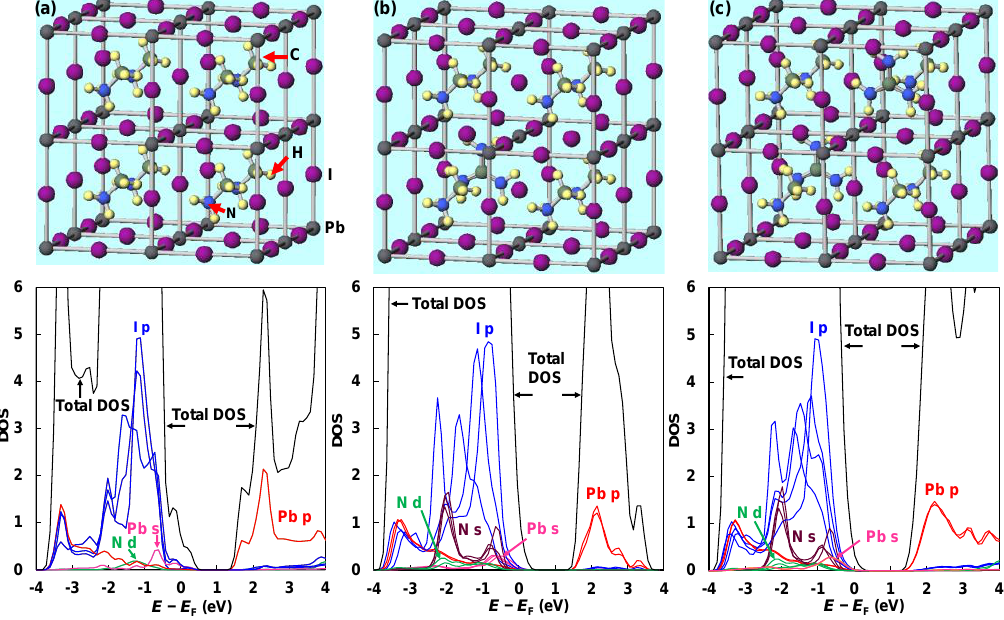
Figure 4. Structure models, density of states, and band structures for ( a ) MAPbI 3 and ( b ) MA 0.875 GA 0.125 PbI 3 and ( c ) MA 0.75 GA 0.25 PbI 3 . Electron density distributions of MA 0.875 GA 0.125 PbI 3 are shown in Figure 5. The electron density distributions around MA and GA are positively charged. The electron density distribution around GA was slightly lower than that around MA on the Pb-I interfaces, which indicates that carriers around GA would flow and stabilize the perovskite crystals. Table 3 shows the bandgap and total energy of the perovskite crystal lattice obtained from the calculation. The bandgap energies of MAPbI 3 and MA 0.875 GA 0.125 PbI 3 are calculated to be 1.33 eV and 1.31 eV, respectively. Calculated results on the total energies indicate the GA addition promotes stabilization of the perovskite crystal, which is expected to suppress the desorption of MA or GA. The GA addition also causes a reduction in the bandgap and increases the number of excited